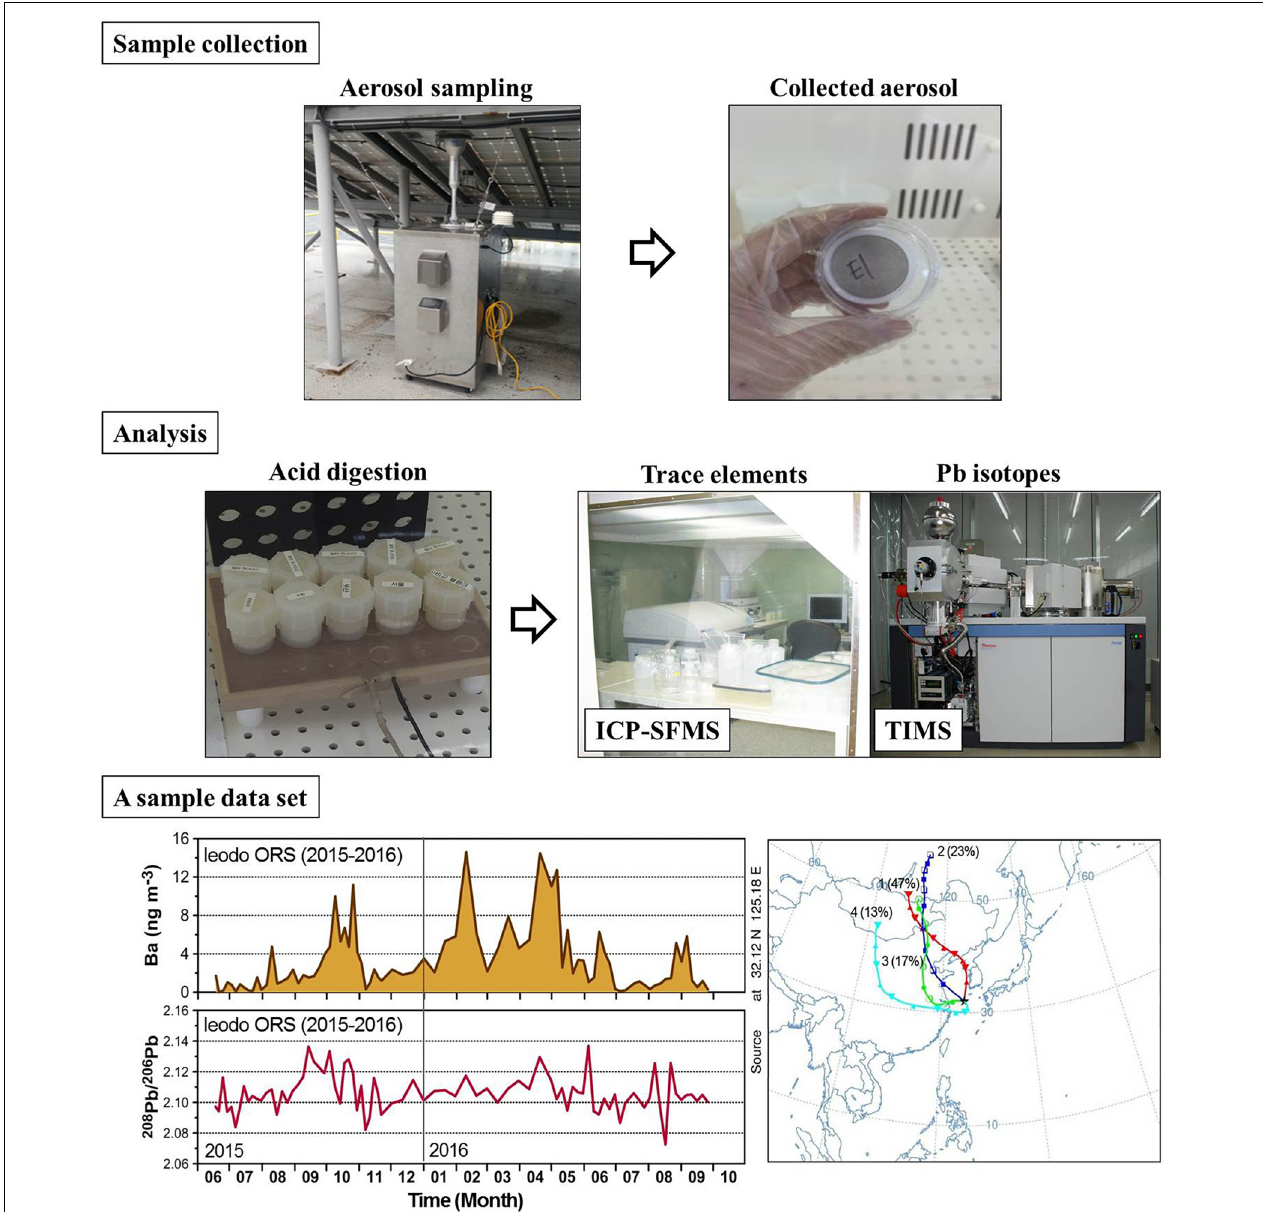
FIGURE 12 | A schematic showing aerosol collection, analysis of the samples, and an example data set (Ba concentration and 208Pb/206Pb ratios) from samples collected between June 18, 2015 and October 1, 2016 and potential source regions estimated by the Hybrid Single Particle Lagrangian Integrated Trajectory (HYSPLIT) cluster analysis of 5-day back trajectories arriving at Ieodo ORS from December 2015 to February 2016.